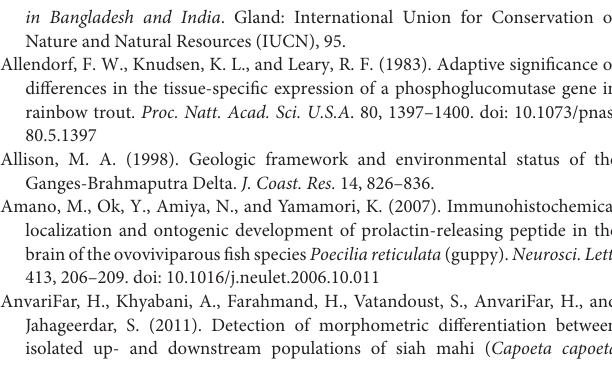
FIGURE S1 | The Principal Component Analysis (PCA) and Linear Discriminant Function Analysis (LDFA) showing the morpho-genetic variation of Hilsa shad Tenualosa ilisha among heterogeneous habitats including the sea, estuary and different rivers. (A) Biplots of the PCA using 22 truss morphometric distances of Hilsa shad; (B) biplots of the LDFA using 22 truss morphometric distances of Hilsa shad; (C) biplots of the PCA using 74 putatively adaptive panels of SNP loci identified by the F ST Outflank approach; (D) biplots of the LDFA using 74 putatively adaptive panels of SNP loci identified by the F ST OutFLANK approach. FIGURE S2 | The cluster analysis showing morpho-genetic variation of Hilsa shad Tenualosa ilisha among heterogeneous habitats including the sea, estuary and different rivers. (A) Neighbor-joining trees, based on the Nei’s genetic distances using the 74 putatively adaptive panel of SNP loci identified by the FST OutFLANK approach. (B) Unweighted pair group method with arithmetic mean (UPGMA) dendrogram of hierarchical cluster analysis based on Euclidean distance using the 22 truss morphometric distances of Hilsa shad population collected from their different